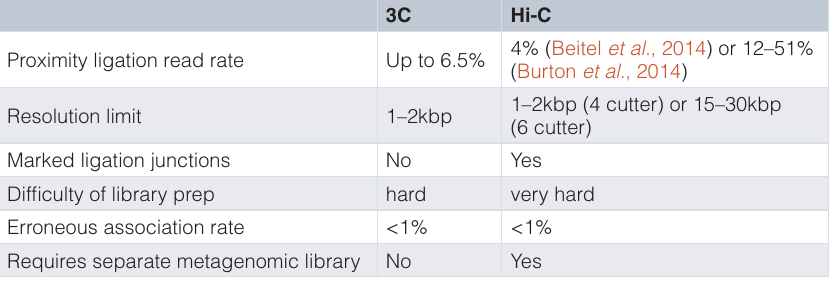
Table 1. Differences in the features of metagenomic 3C and Hi-C are listed. The proximity ligation read rate indicates the fraction of all reads that contain proximity ligation events. For Hi-C the rate varies widely in published data. The resolution limit is dictated by the density of restriction cut sites in the chromosome, which are typically more dense when using a 4-cutter (3C or Hi-C), than with a 6-cutter (Hi-C only). Marked ligation junctions are created as a by-product of the end-filling in Hi-C and can be identified as a tandem duplication of the overhang sequence in the data. The erroneous association rate is defined as the fraction of read pairs found to associate two different species or strains in mock community